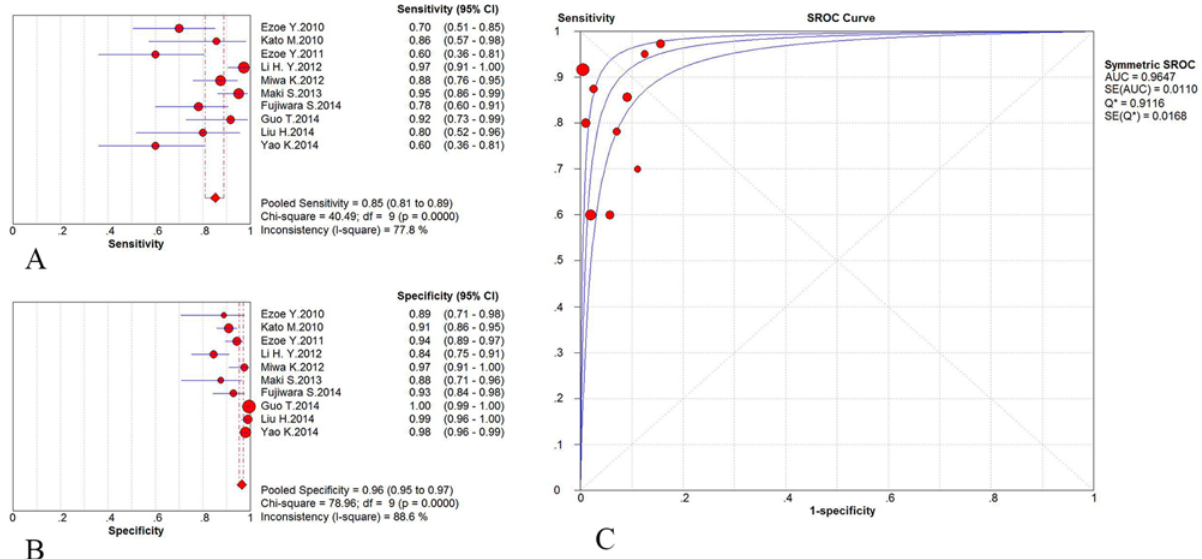
Fig 2. Analysis of the diagnostic efficacy results of ME-NBI. A: Pooled sensitivity of ME-NBI for diagnosing gastric neoplasms. B: Pooled specificity of ME-NBI for diagnosing gastric neoplasms. C: Symmetric receiver operating characteristic (SROC) curve and area under the curve (AUC).